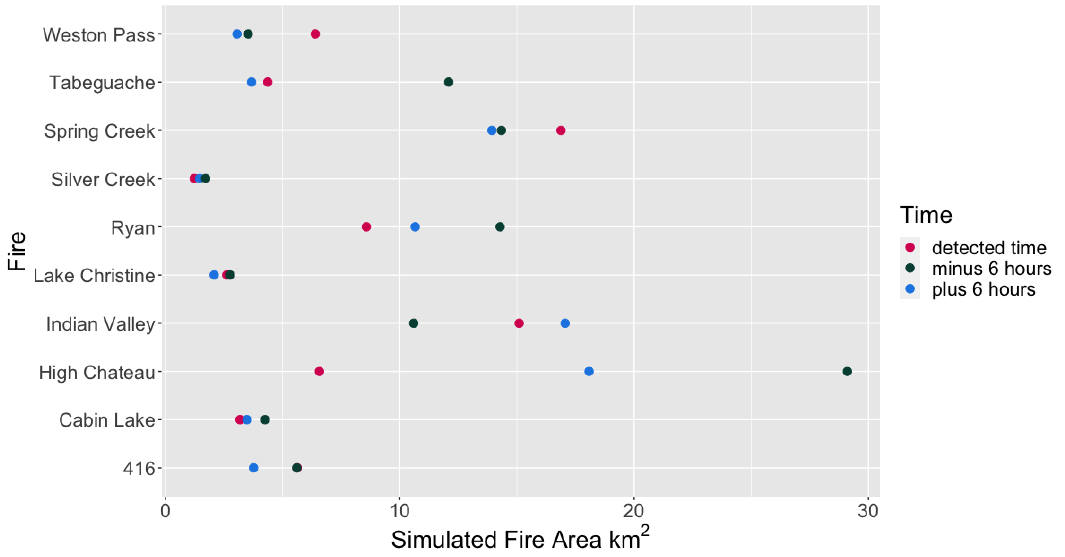
Figure 7. Forecast burned area at each case study’s detection location initiated at the detection time (magenta), six hours before (dark green) and six hours after